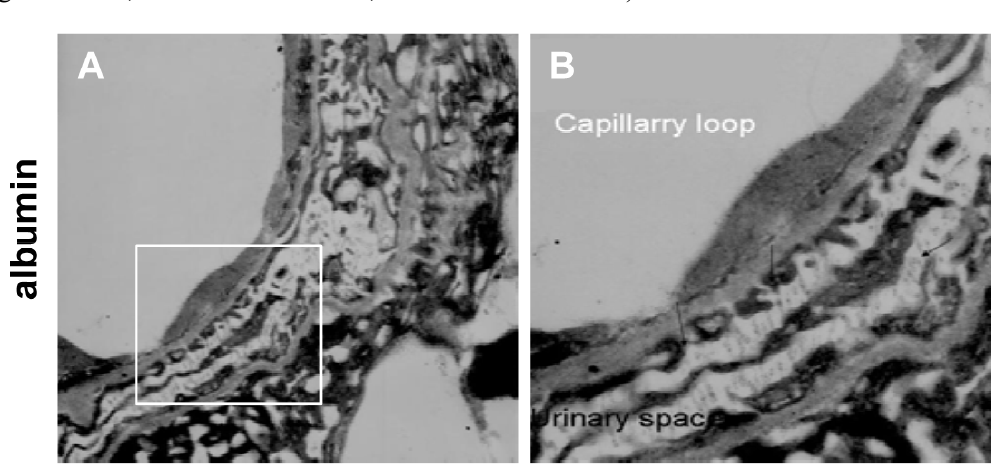
Figure 2. Immune electron micrographs of albumin and IgG in the glomerular filtration membrane under acute hypertensive conditions. Under the acute hypertensive condition, the distributions of albumin ( A , B ) and IgG ( C , D ) were changed. Both albumin and IgG were clearly immunolocalized along the apical surface of the podocytes and Bowman's spaces (arrows). In addition, podocyte fusion and reduced microvilli could be observed. (Magnification, ×8000 for A and C, ×12000 for B and